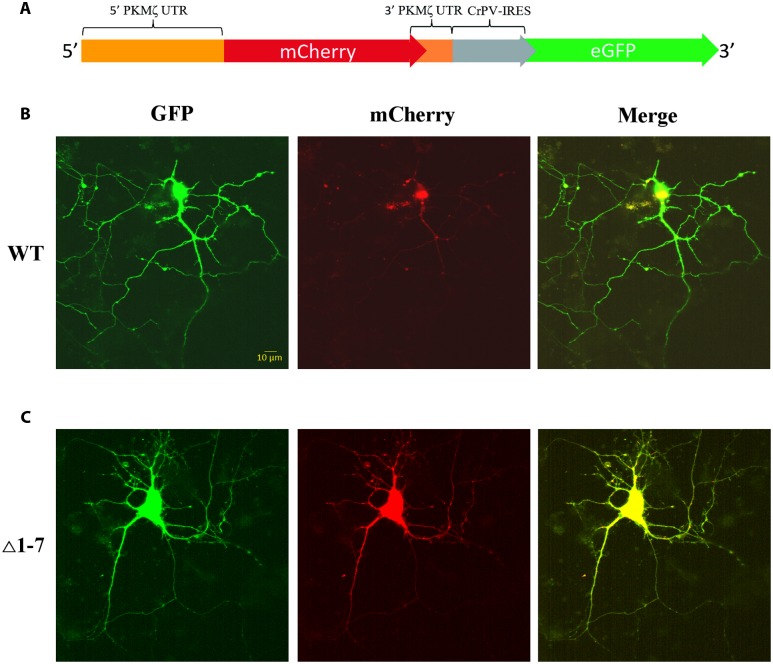
Expression of mRNAs under control of regulatory elements of PKMζ 5′UTR in the primary neuron culture from rat hippocampus.
(A) Structure of genetic constructions used for expression of mRNA in neurons. Wild-type or mutated leaders of PKMζ are followed by mCherry gene under CMV promoter and GFP gene under control of CrPV IRES element. (B) Expression of mRNA with wt 5′UTR of PKMζ in the primary neuron culture from rat hippocampus. (C) Expression of mRNA with Δ1–7 5′UTR of PKMζ in the primary neuron culture from rat hippocampus. Expression of eGFP serves as a control, and reflects a possible level of protein synthesis without repression.